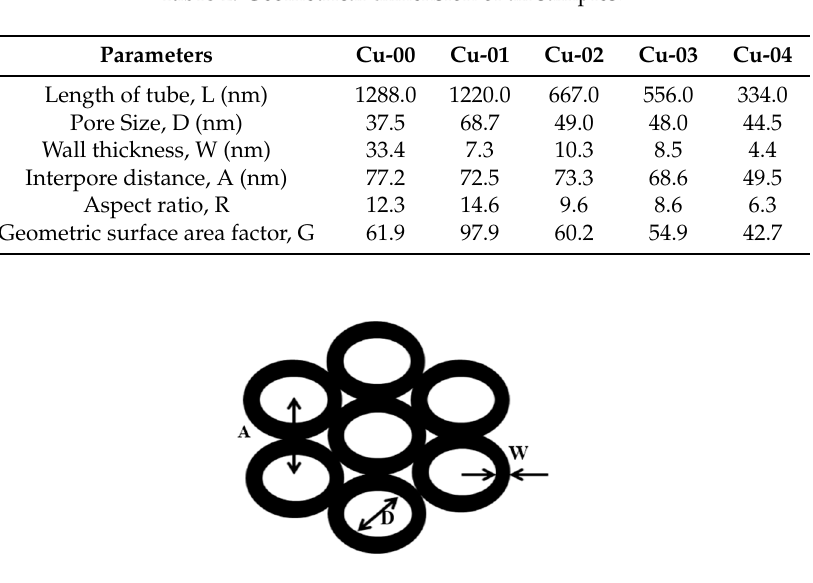
Figure 2. Idealized geometric relationships in hexagonal nanotubular array with a wall thickness (W), interpore distance (A), and pore size (D). Catalysts 2016 , 6 , 167